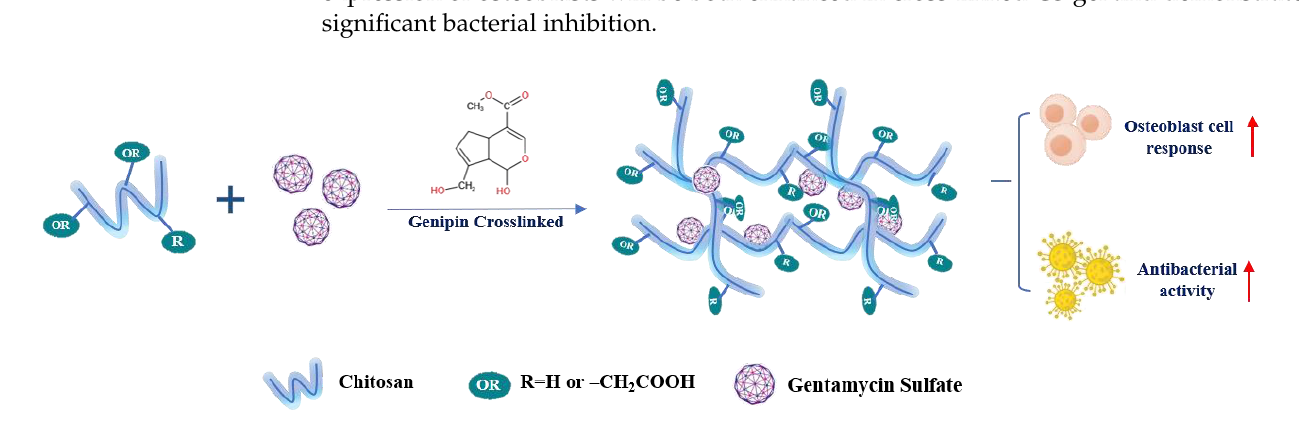
Figure 3. Schematic drawing of the preparation of the chitosan hydrogel.